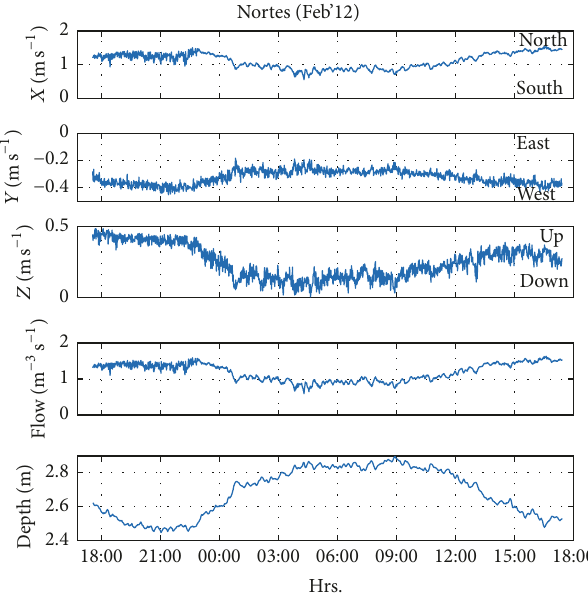
Figure 3: Direction, velocity, and flux in X’Buya-Ha spring in dry season (May 2013). The 𝑥 -axis shows 24 hours of observation from 0:00 on